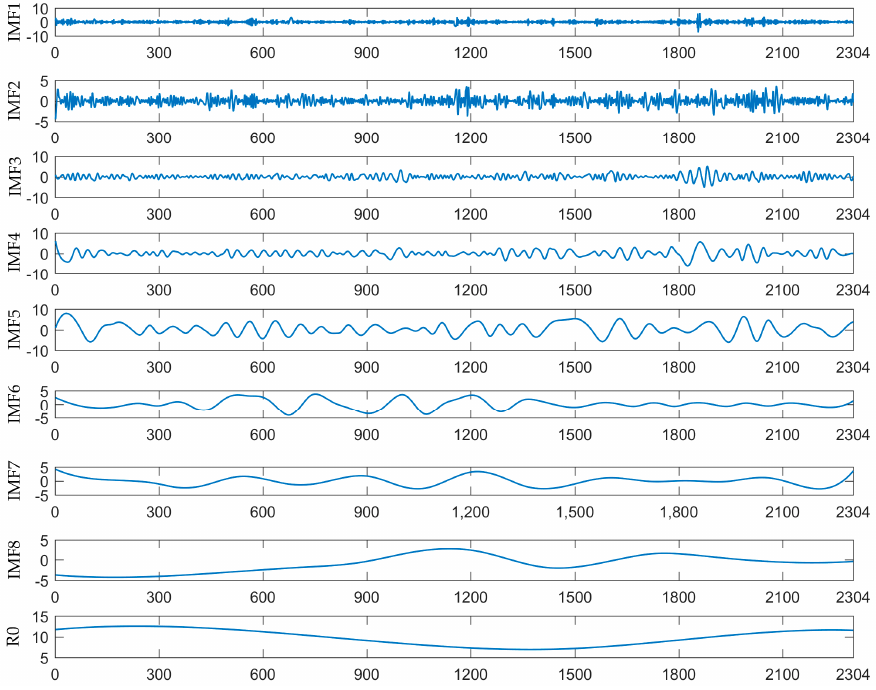
Figure 6. The EMD results of original wind speed series.